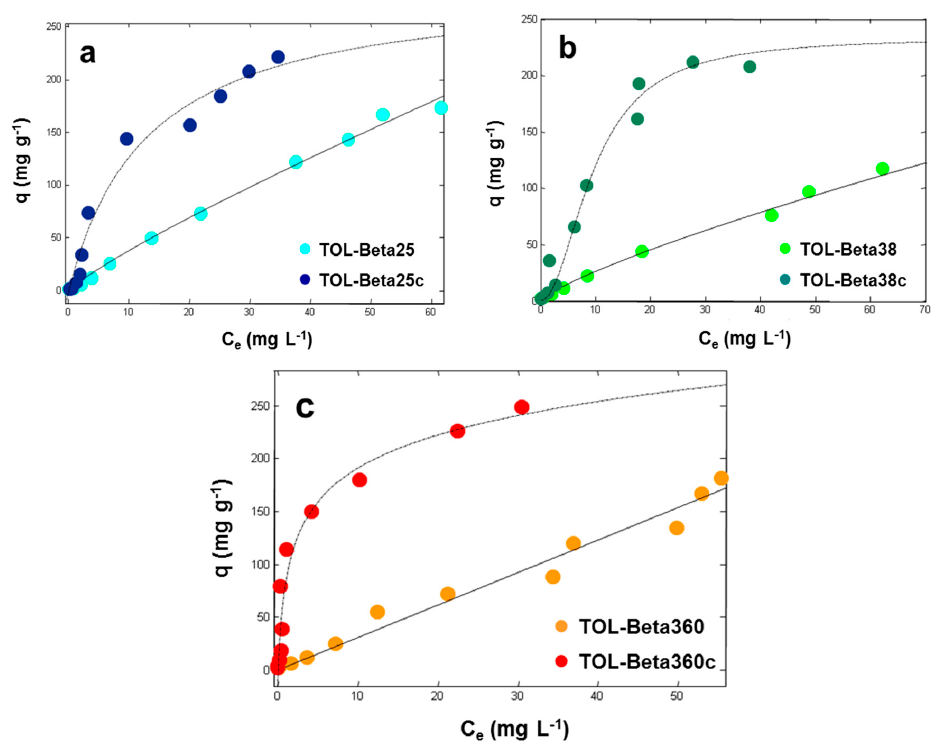
Figure 2. Adsorption isotherms of TOL on ( a ) Beta25 (light blue circles: as-received, dark blue circles: calcined); ( b ) Beta38 (light green circles: as-received, dark green circles: calcined) and ( c ) Beta360 (orange circles: as-received, red circles: calcined). Table 2. Isotherm parameters for the adsorption of TOL on as-received BEAs estimated by non-linear fitting, according to the Freundlich model. The confidence limits at 95% of probability of the estimated parameters are reported in brackets.